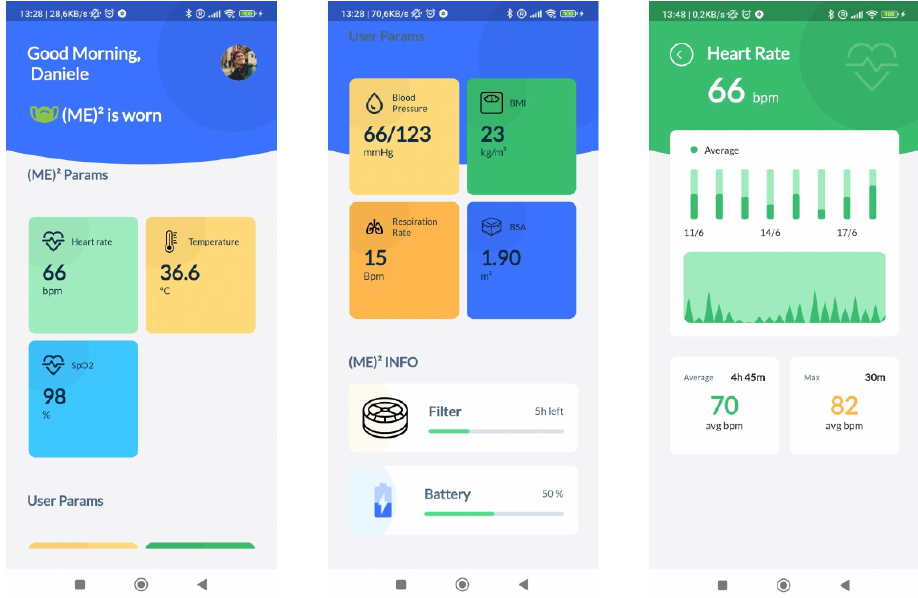
Figure 5. (ME) 2 app on Android. The homepage displays general details, if the mask is worn, real-time vital signs heart rate, body temperature, and oxygen saturation, other offline health data, user general information, filter life status, and battery life